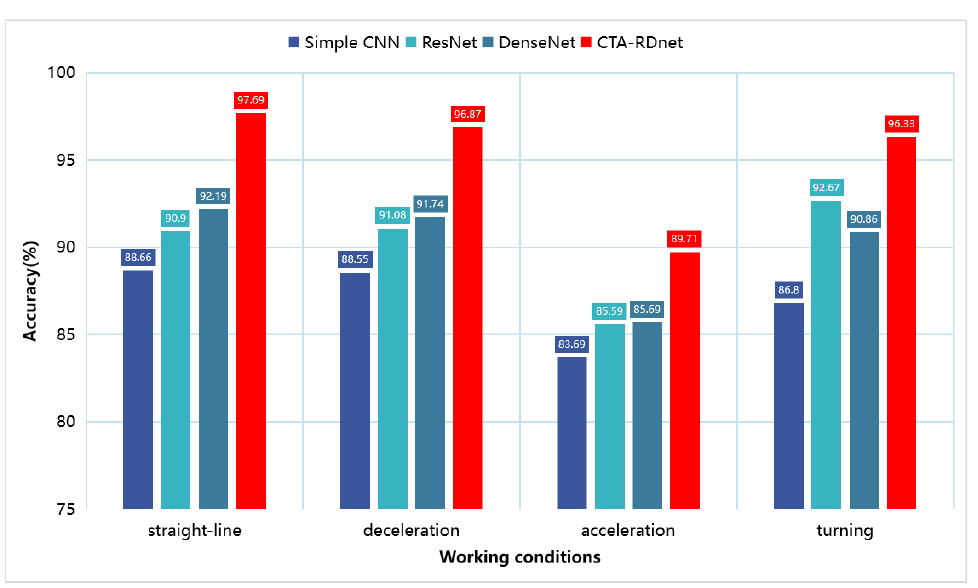
Figure 13. The recognition accuracy of different models under matching of working conditions.